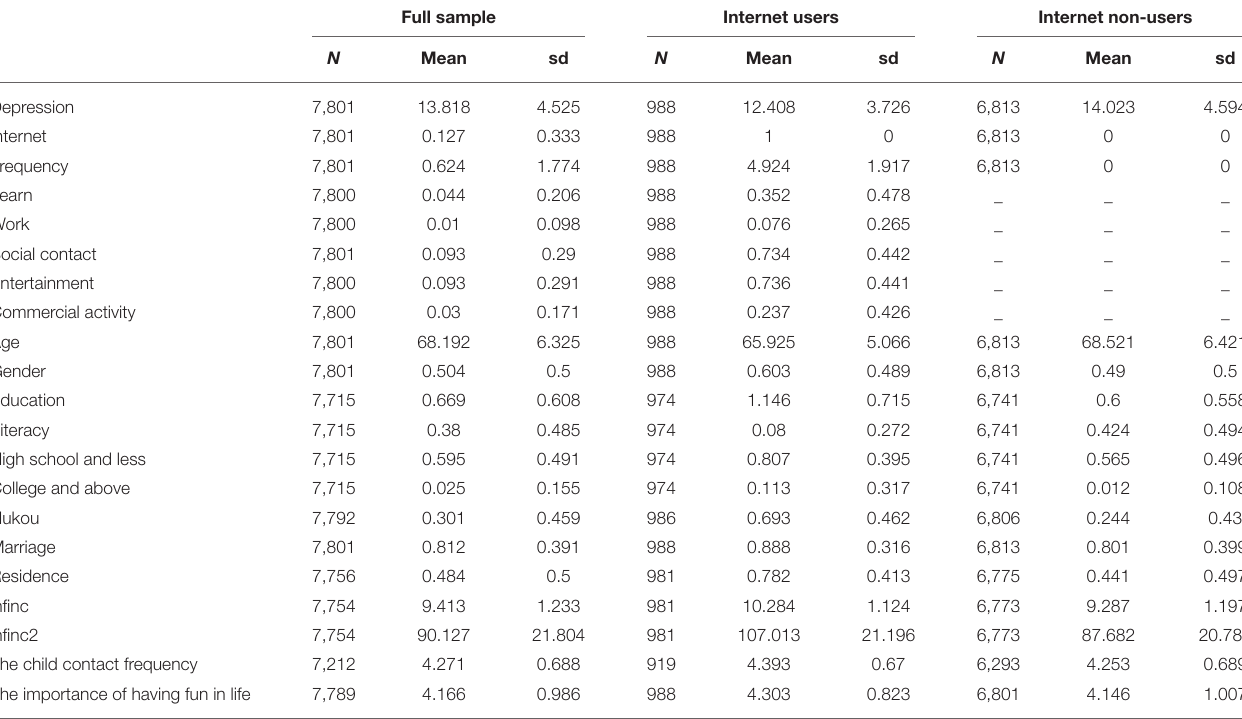
TABLE 1 | Descriptive statistics for the sample.